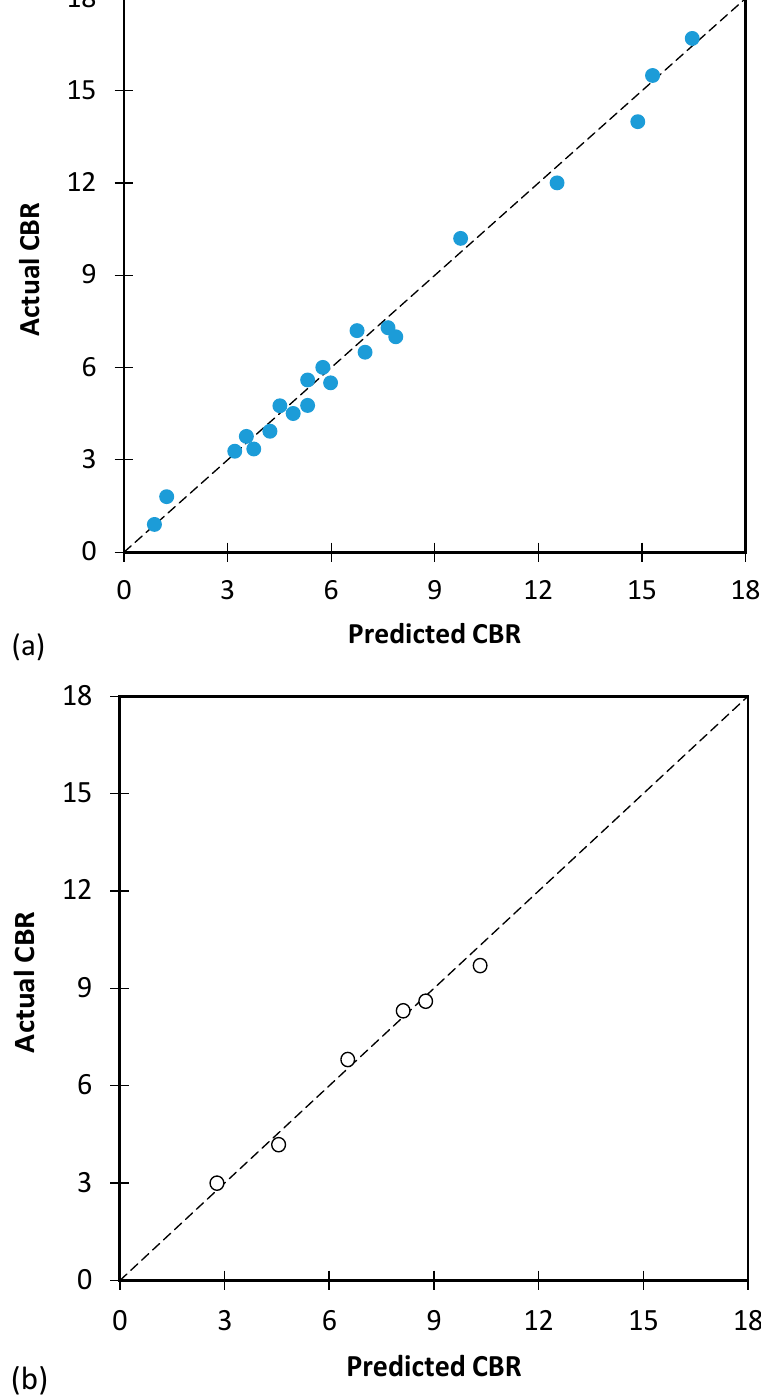
Figure 8. The results of the best ANN model predicting the CBR values for the ( a ) training and ( b ) testing databases.